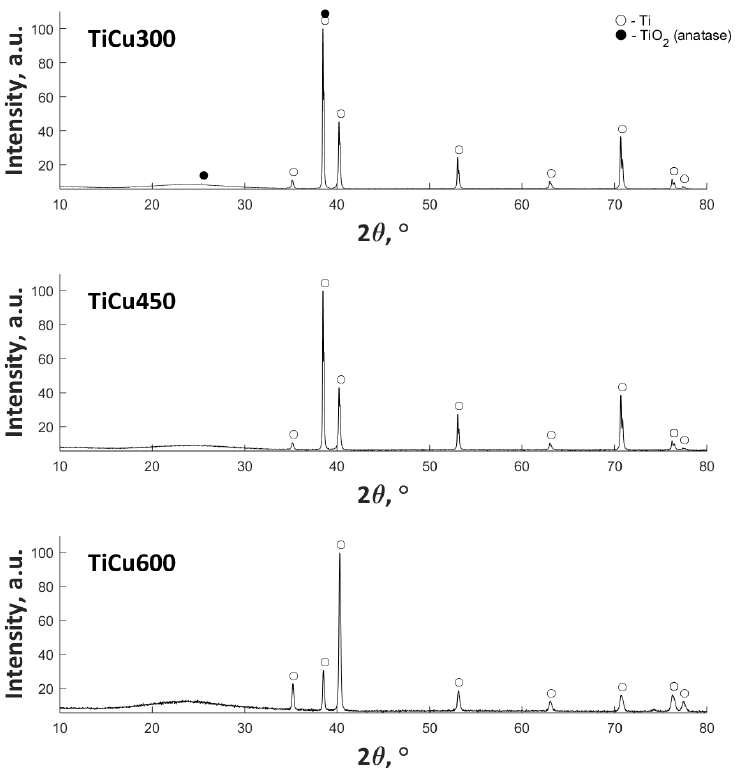
Figure 6. XRD diffractograms of PEO coatings (left side) and corresponding copper-to-phosphorus (Cu/P) ratios (right side) of the three coatings: TiCu300 ( a ), TiCu450 ( b ), and TiCu600 ( c ).